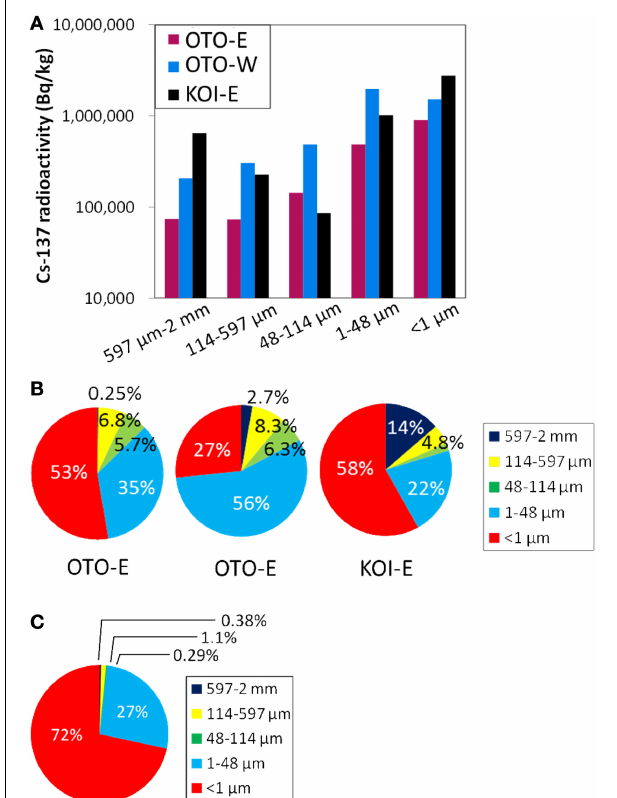
FIGURE 3 | (A) The 137 Cs radioactivity of the three samples separated to the five size fractions; < 1, 1–48, 48–114, 114–597 μ m, and 597 μ m–2mm. (B) A pie diagram of (A) showing the percentage of radioactivity in each size fraction. (C) A pie diagram of the size-dependent radioactivity of the KOI-E sample ultrasonicated twice after obtaining (B)